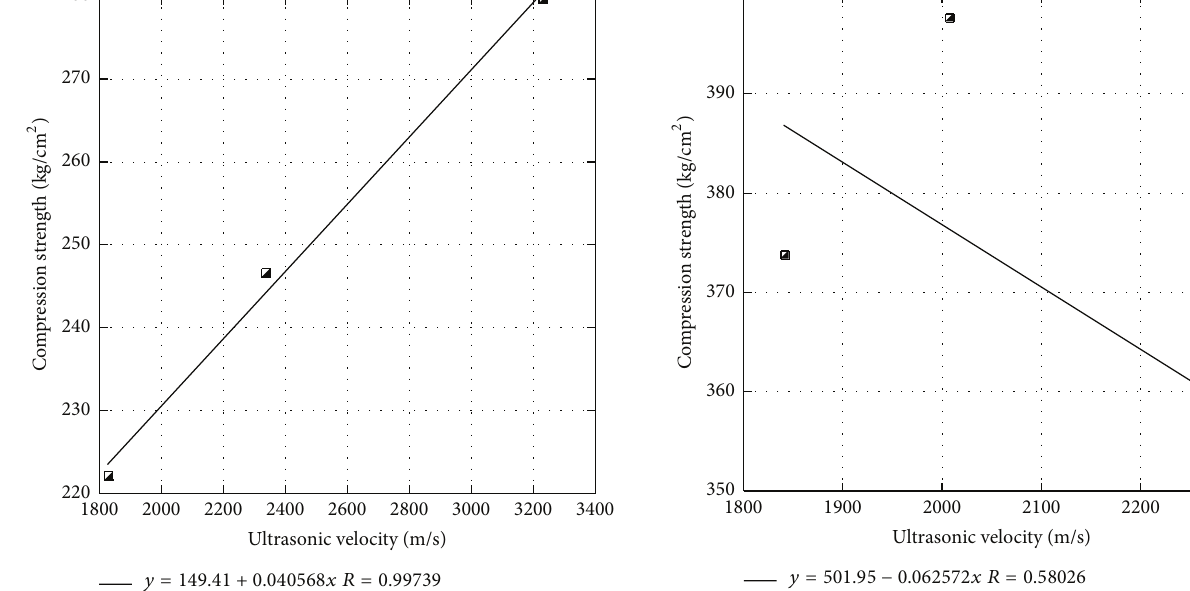
Figure 9: Correlation between UPV and compression strength for train A/B.